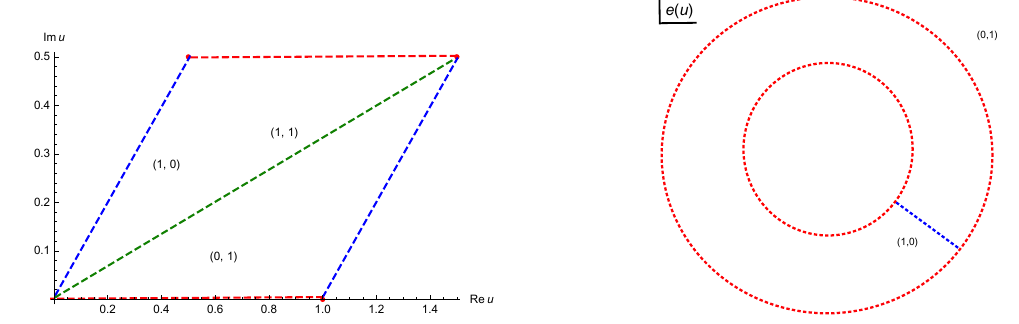
Figure 1 . The saddle-point con(cid:12)gurations of eigenvalues in the fundamental domain and on the torus for (cid:28) = 1 (1 + i). The saddles shown are (0 ; 1) (red), (1 ; 0) (blue), and (1 ; 1) (green). The 2 original de(cid:12)nition of the matrix model is the interval [0 ; 1) on the left which maps to the outer circle of unit radius on the